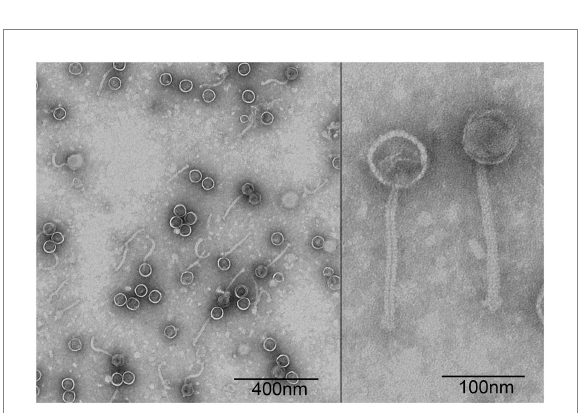
FIGURE 2 Transmission electron micrograph of φ PaP11-13, negatively stained with 2% uranyl acetate.